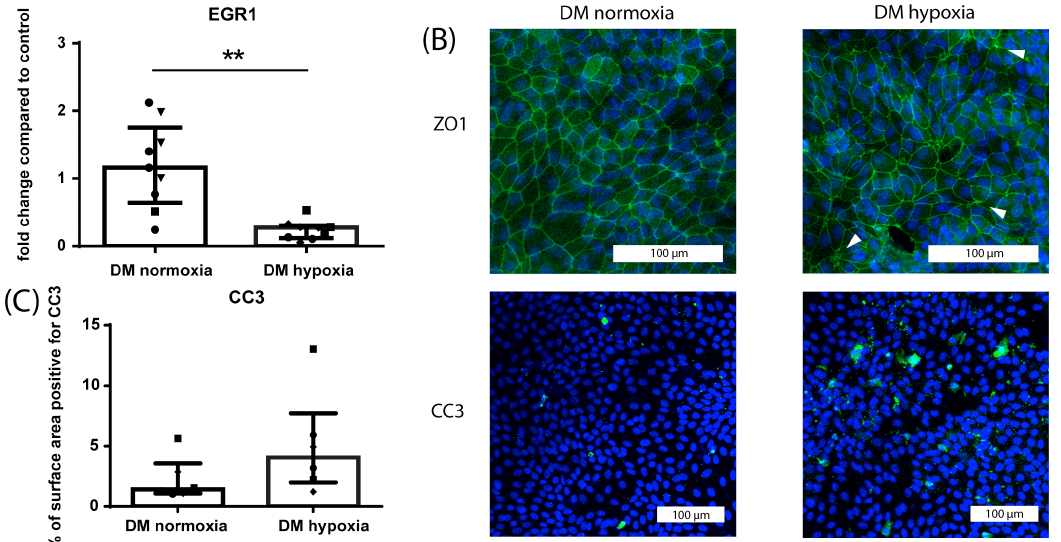
Figure 4. Effects of hypoxia on villus-like (DM-cultured) HIO (monolayer-cultured). ( A ) mRNA expression of IL8 (pro-inflammatory cytokine), OLFM4 (stem cells), LYZ (Paneth cells), PEPT1 (di/tri- peptide transporter), LAT2 (amino acid transporter) and HIF1A (hypoxia-regulated transcription factor) following 48 h of hypoxia (1% O 2 ) in villus-like HIO monolayers. Data are reported as relative expression compared to normoxia (set at 1) and displayed as median with interquartile range. Results were obtained from three different HIO donors (depicted by different data point symbols, one symbol type per donor). * p ≤ 0.05, ** p ≤ 0.01, *** p ≤ 0.001. ( B ) Representative images from immunofluorescence staining of ZO1 in villus-like HIO monolayers exposed to hypoxia for 24 h compared to normoxic controls. Results were obtained from three different HIO donors. Scale bars indicate 100 µ m. ( C ) Analysis of the % of surface area positive for CC3 and representative images from immunofluorescence staining of CC3 in villus-like HIO monolayers exposed to hypoxia for 24 h compared to normoxic controls. Data are displayed as median with interquartile range. Results were obtained from three different HIO donors (depicted by different data point symbols, one symbol type per donor). Scale bars indicate 100 µ m. Abbreviations: IL8—interleukin 8; OLFM4—olfactomedin